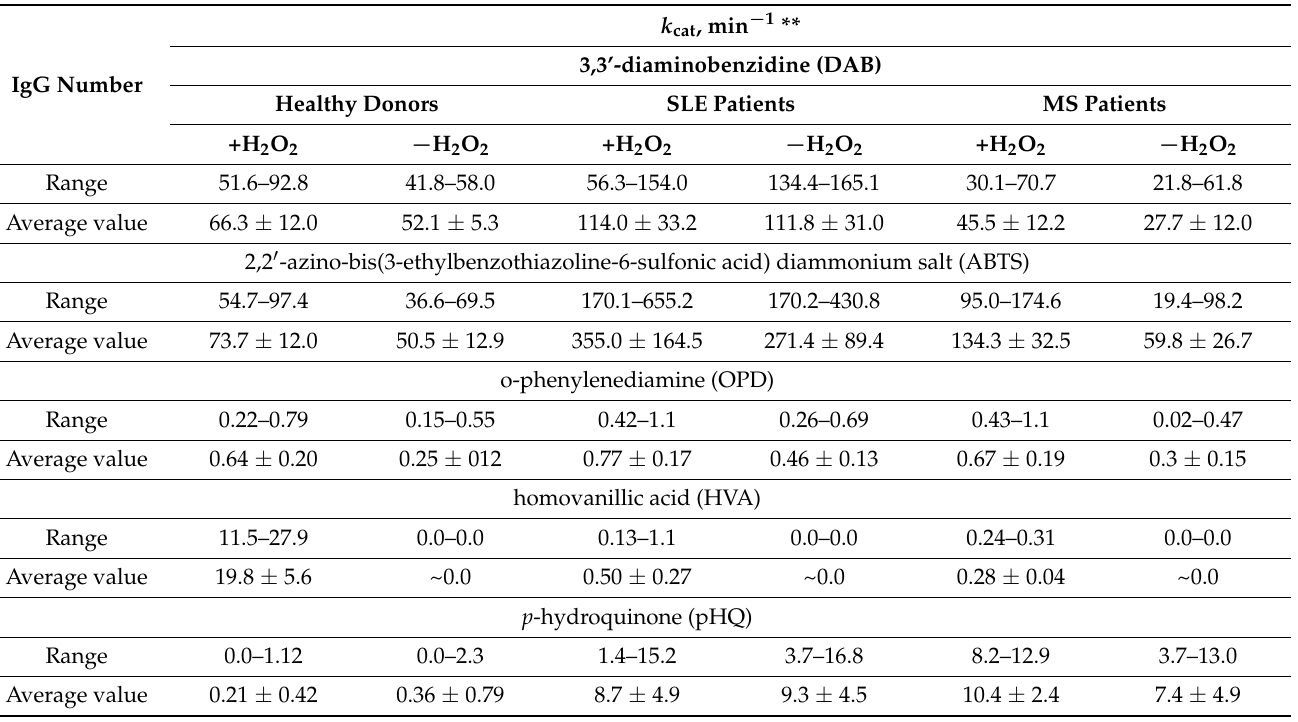
Table 1. The apparent k cat values characterizing peroxidase and oxydoreductase activity of indi- vidual IgGs from the sera of healthy donors, patients with SLE and MS in the oxidation of five substrates [188] *.